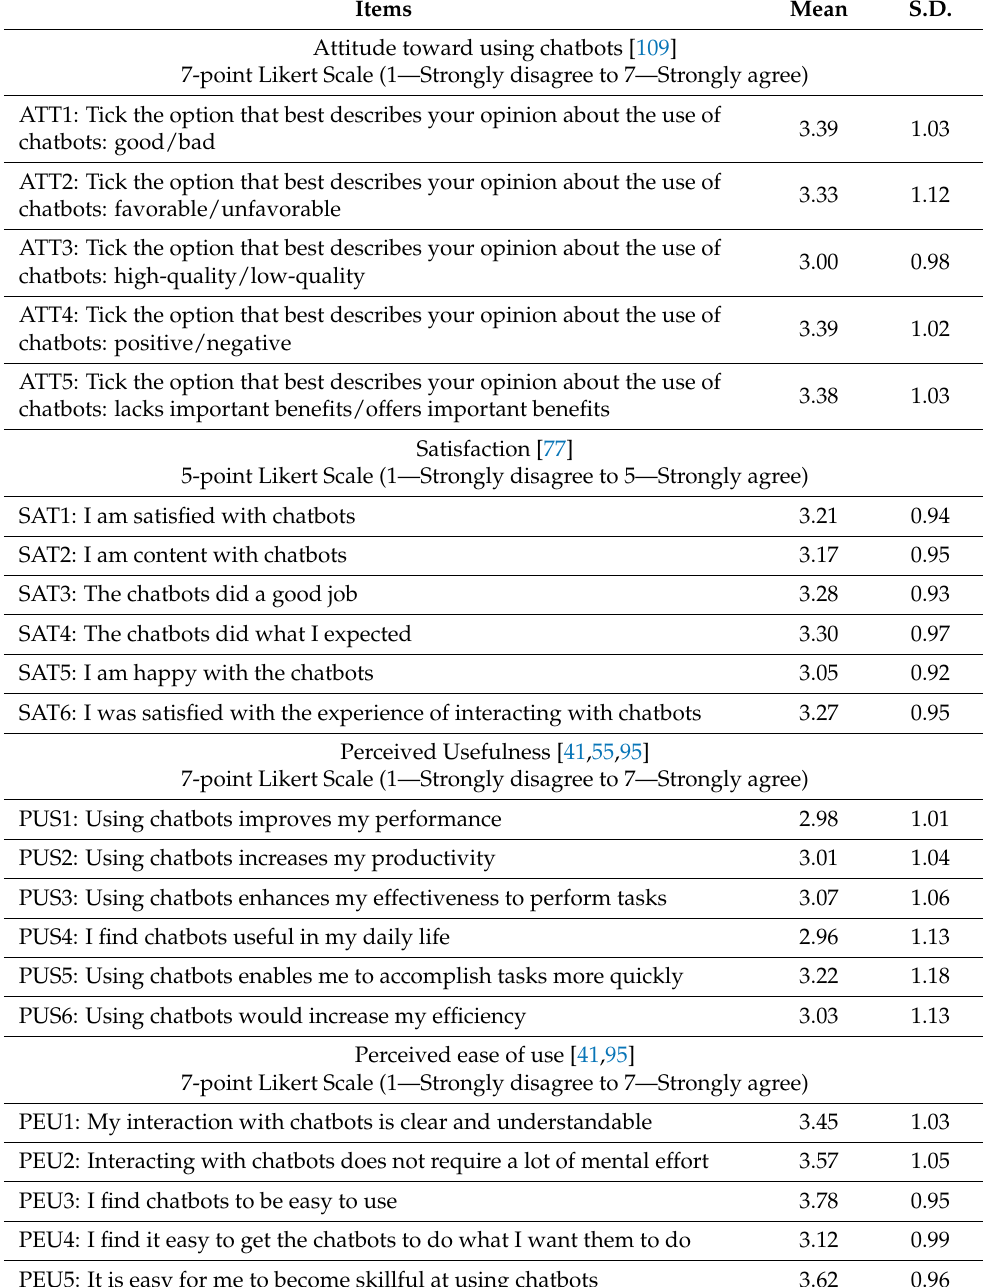
Table 1. Measurement items and descriptive